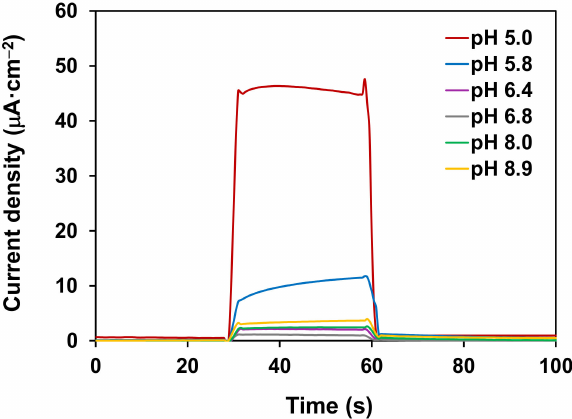
Figure 4. Chronoamperometry experiment with ATO-Co-cyt c at various pH values. 100 mM citrate buffer was used for pH 5.0, 5.8, and 6.4, and Tris buffer was used for pH 6.8, 8.0, and 8.9. The applied potential bias was 0.25 V vs. RHE.